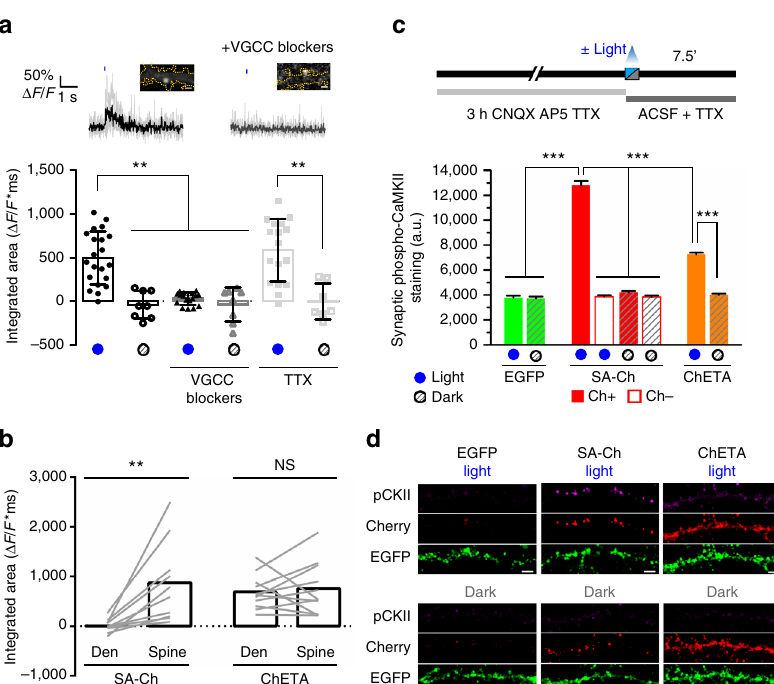
Fig. 4 Optogenetic activation of SA-Ch in neurons. a Activation of SA-Ch by means of 488 nm laser illumination drives calcium in fl ux in the neuron. GCaMP6s was expressed along with SA-Ch and illuminated at 990 nm. Top, example of GCaMP6s Δ F/F time course following 10 ms light stimulation (blue mark above) in ACSF (left, black trace) or in ACSF with voltage-gated calcium channel (VGCC) blockers nifedipine, Ni 2+ , and Zn 2+ (right, gray trace). Single traces are in light gray and bold lines are the average. Above images show SA-Ch fl uorescence in corresponding spines and yellow dotted trace shows neuron pro fi le as inferred from GCaMP6s fl uorescence; scale bar, 1 μ m. Bottom, integrated area of Δ F / F against time plot after light stimulation for imaged spines with (blue dots below) or without (gray dots) light stimulation. SA-Ch neurons were recorded in standard ACSF (black, circles) or in ACSF in the presence of either VGCC inhibitors (dark gray, triangles) or TTX (light gray, squares); open symbols represent recordings in the same medium as corresponding fi lled symbols, without illumination. Data are values for single spines, each represents the average of trains on the same spine, bars are mean ± SD. ** P < 0.01, Kruskal – Wallis test, Dunn ’ s post-hoc comparisons. b Illumination of spines in SA-Ch-expressing neurons drives calcium in fl ux, but not when laser illumination is focused on the nearby dendrite. Conversely, ChETA neurons can be excited both by a spine-focused and a dendrite-focused laser beam. ** P < 0.01 paired Student ’ s t- test, two-tailed. NS, not signi fi cant at the α = 0.05 level. Lines connect single paired data points, bars are mean. c Outline of time course of the experiment. Cells were pretreated for 3 h with CNQX, AP5, and TTX, to reduce background CaMKII activation. Neurons were fi xed 7.5 min after light stimulation and stained for phospho-CaMKII. Spines in SA-Ch-expressing neurons were subgrouped into Cherry-positive ( fi lled bars) and Cherry-negative spines (empty bars). Light stimulation induced a signi fi cant increase of phospho-CaMKII staining in SA-Ch-expressing spines *** P < 0.001, one-way ANOVA, Bonferroni comparison of means. Bars are mean ± SEM. d Representative images of data shown in c . Panels show phospho-CaMKII immuno fl uorescence (p-CKII), anti-Cherry immuno fl uorescence (Cherry), and EGFP signal. Scale bar, 5 μ